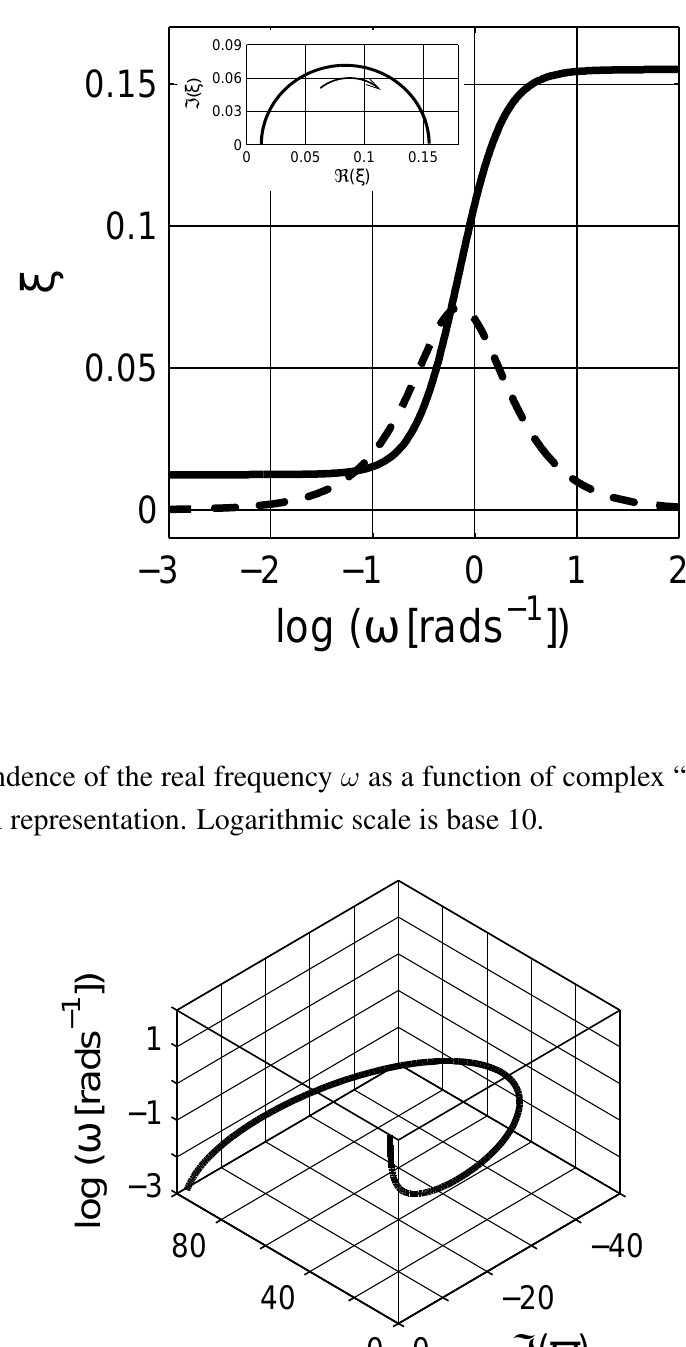
Figure 3 . The real ( (cid:60) ( ξ ) ; ——–) and the imaginary ( (cid:61) ( ξ ) ; – – –) parts of scaled permittivity ξ in the Maxwell Garnett approximation. Inset is the Argand diagram for ξ with the arrow showing the direction of increasing angular frequency ω . The inclusions are spherical d = 3 , and q = 0 . 3 . Logarithmic scale is base 10.